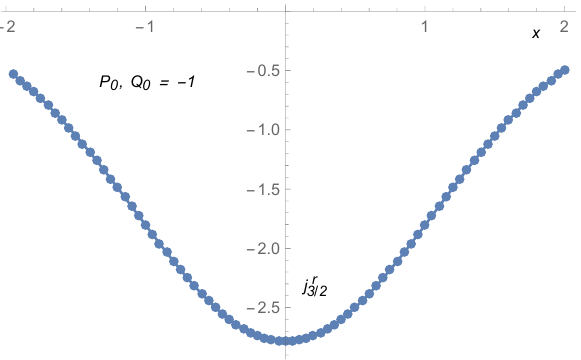
( X ) for the same packet as in Figure 1. It is important to note Figure 2. Re-scaled current density j r 3/2 here (for the comparison of the magnitudes of I and j in the microscopic case, see Section 2.3) that the derivative ∂ j / ∂ X is almost of the same order of magnitude as I